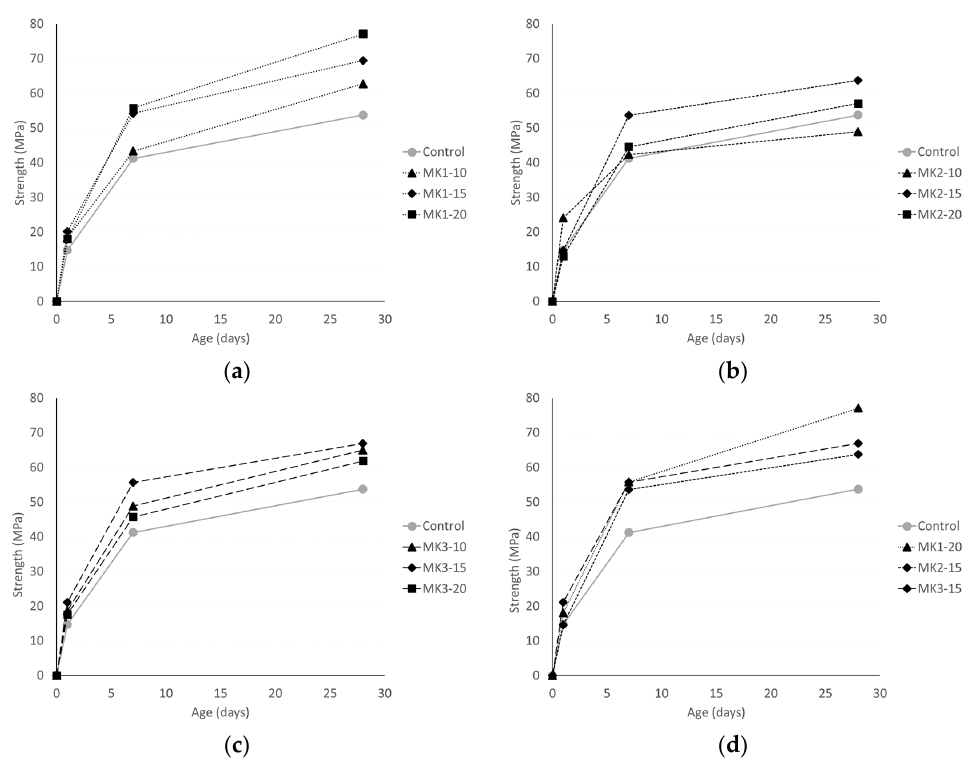
Figure 3. Compressive strength evolution for concretes incorporating metakaolin product: ( a ) MK1; ( b ) MK2; ( c ) MK3; Compressive strength evolution of: ( d ) optimum mixture based on 28-day strength. Table 4. Air content and unit weight of the mixtures.